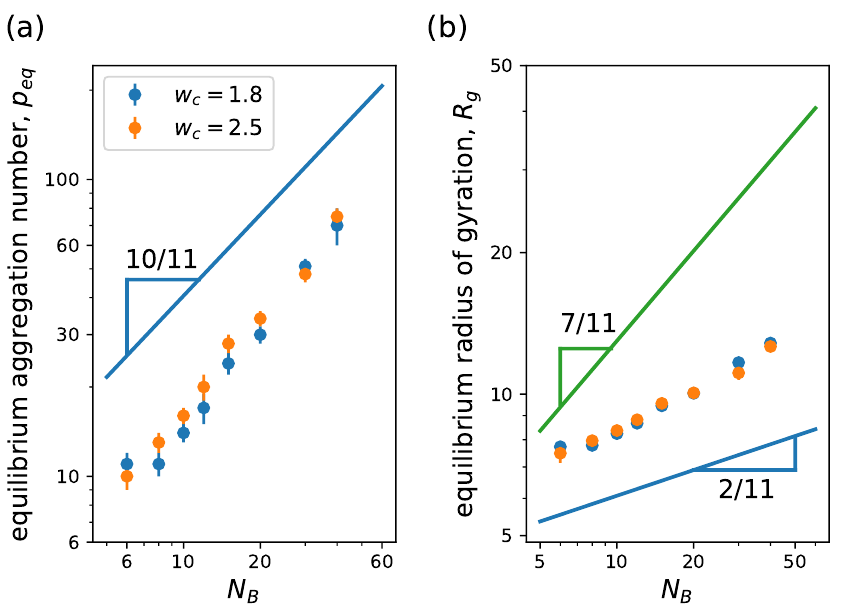
Figure 8. ( a ) Equilibrium aggregation number and ( b ) equilibrium radius of gyration versus degree of polymerization of the hydrophobic block N B . We consider linear–dendritic neutral block copolymer with N A = 120 ( g = 3, q = 3, N s = 3). Lines correspond to scaling behavior predictions from mean-field SCF theory [47]. In ( b ), the blue line corresponds to the scaling of the corona size ∝ N 2/11 and the green line B to the scaling of the core ∝ N 7/11 . Other system parameters: w c = 1.8;2.5, (cid:101) attr = 1.0 and k B T = B